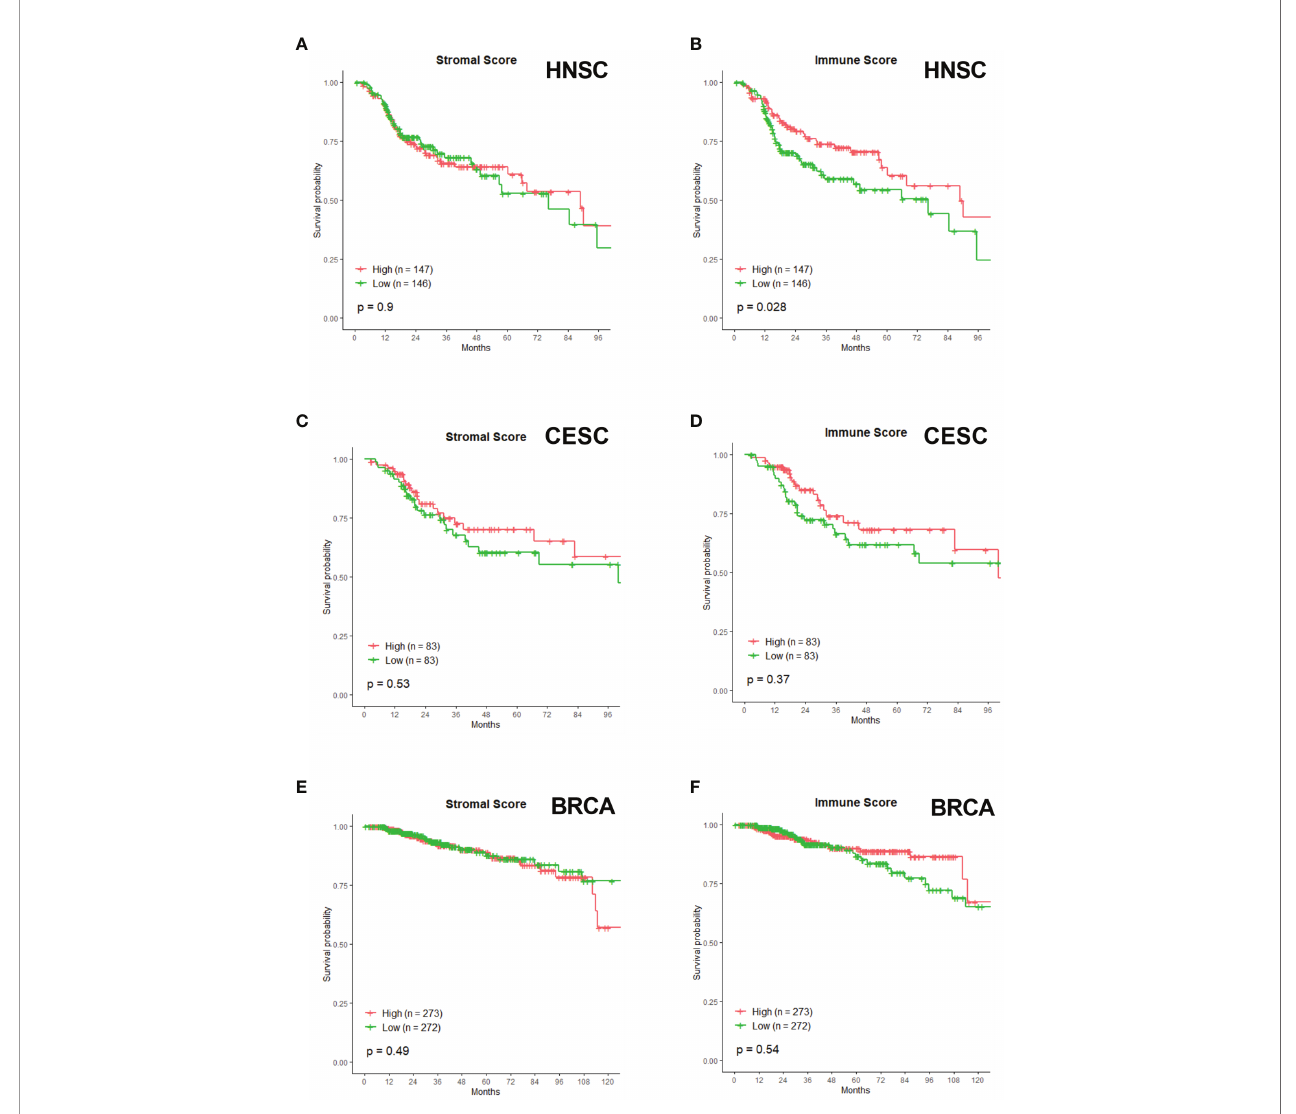
FIGURE 6 | Associations of Stromal and Immune score with patient overall survival times. Kaplan-Meier plots of OS of HNSC patients with (A) Stromal Score and (B) Immune Score. Kaplan-Meier plots of OS of CESC patients with (C) Stromal Score and (D) Immune Score. Kaplan-Meier plots of OS of BRCA patients with (E) Stromal Score and (F) Immune